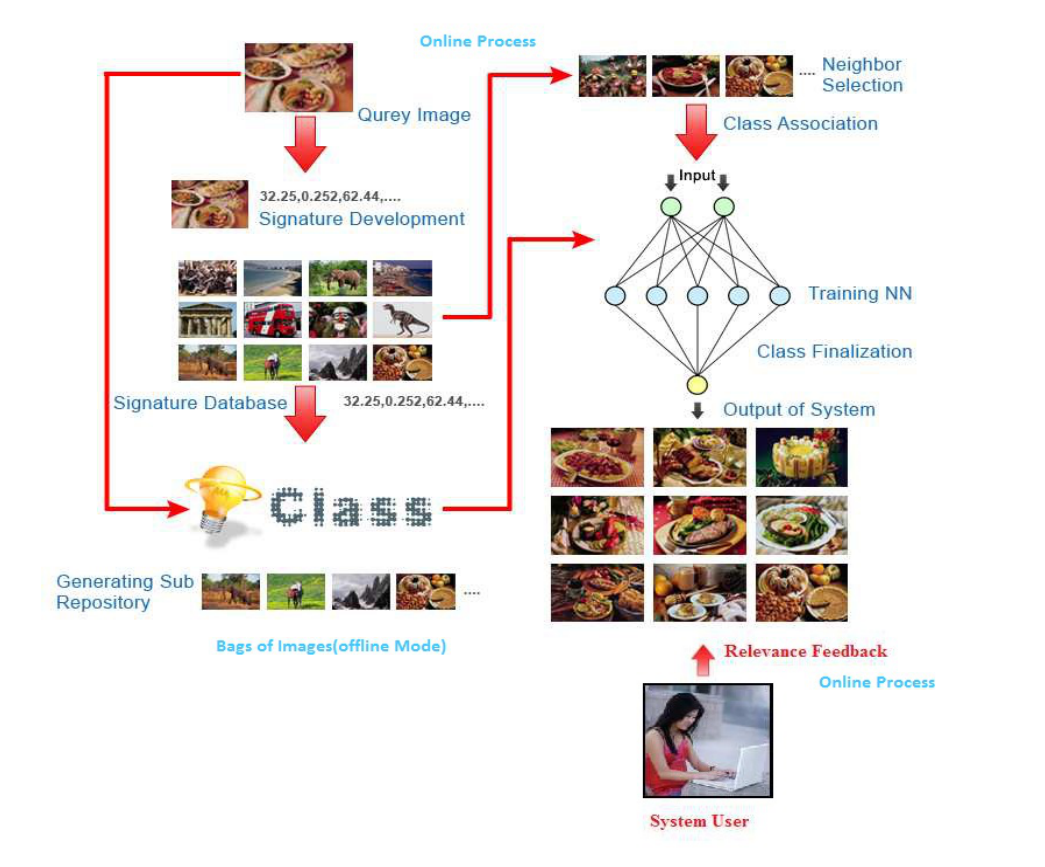
Fig. 2. Architecture of the proposed